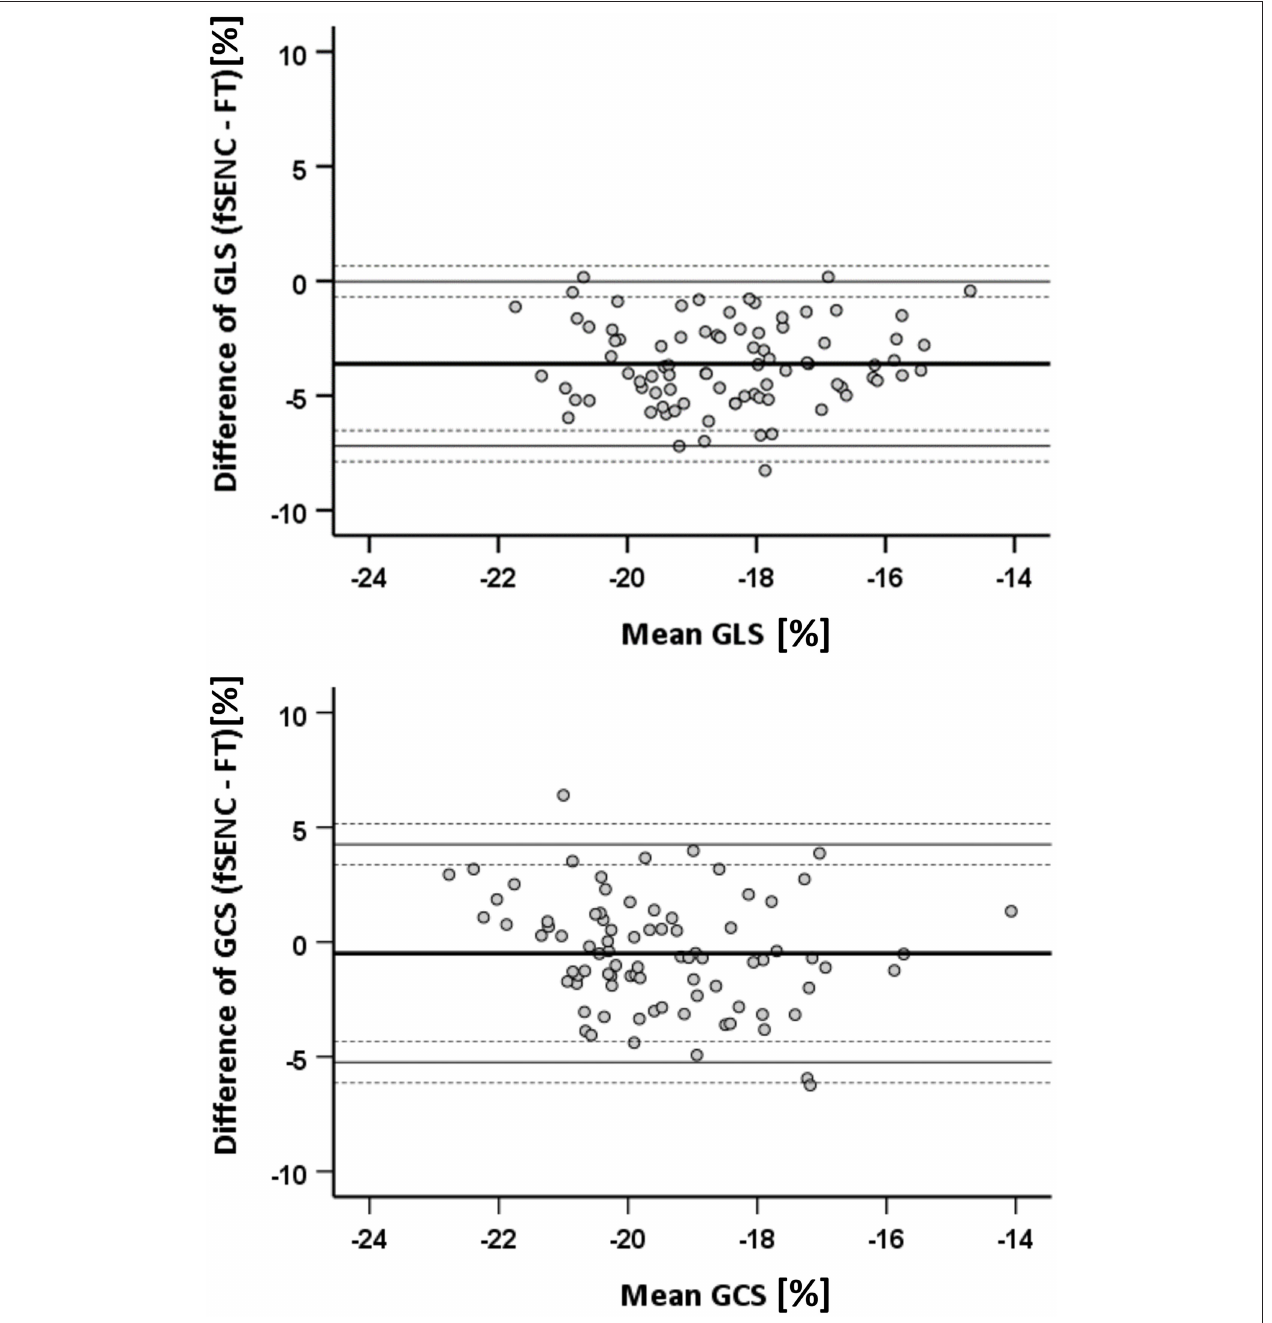
FIGURE 8 | Bland-Altman statistics for comparison of FT and fSENC. GLS, global longitudinal strain; GCS, global circumferential strain.